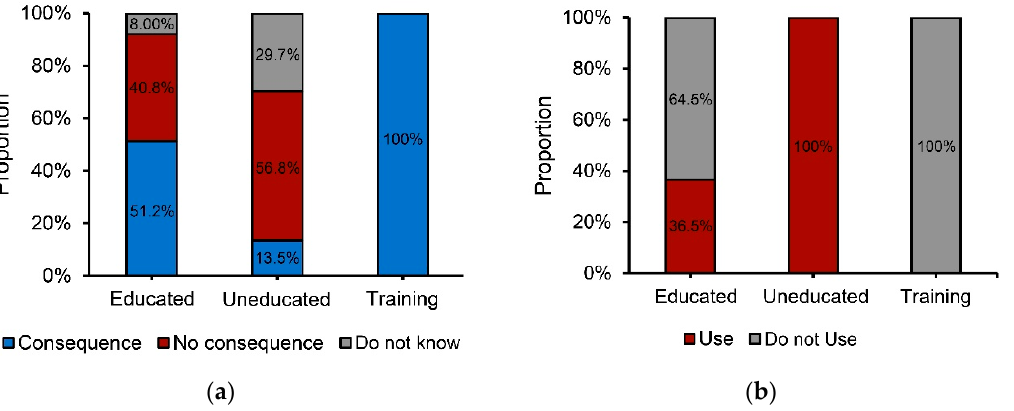
Figure 6. Perception of different cotton farmers on the use of chemical input. ( a ) Understanding of the adverse effects of chemical inputs. ( b ) Use of cotton chemical inputs in food crops.